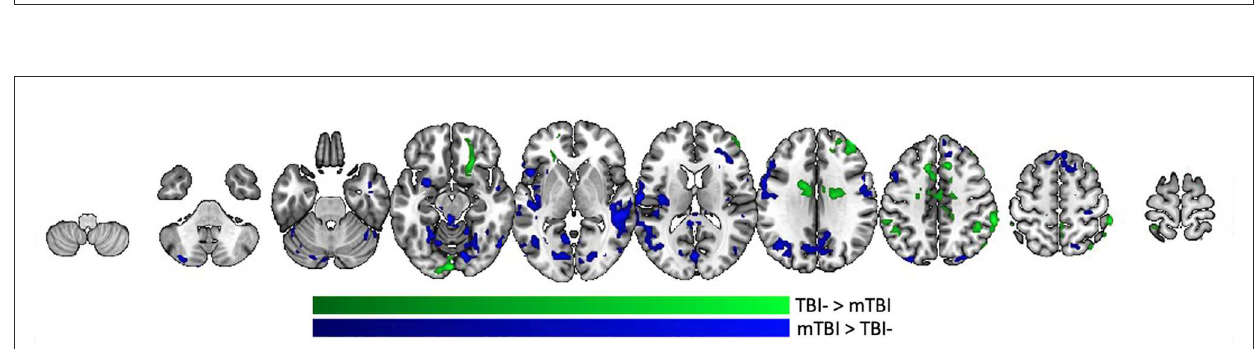
FIGURE5 Group differences in PCL-5 effect on amygdala functional connectivity. Regions in the brain that are differentially functionally correlated with amygdala between the TBI- and mTBI groups. Regions where the slope between amygdala functional connectivity and PCL-5 score is greater in the TBI-group are represented in green. Regions where the slope between amygdala functional connectivity and PCL-5 score is greater in the mTBI group are represented in